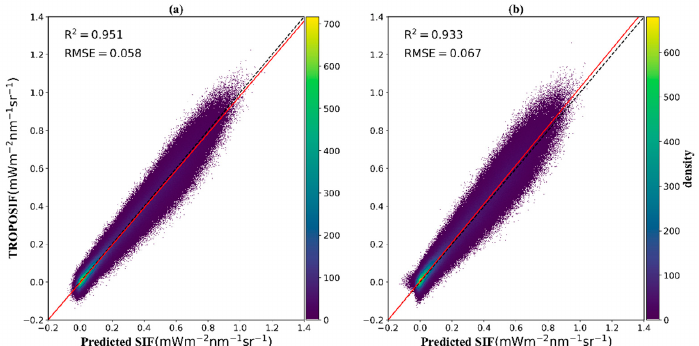
Figure 4. The scatterplots of TROPOSIF and predicted TSIF for training and validation; ( a , b ) for our local models and ( c , d ) for the universal model.